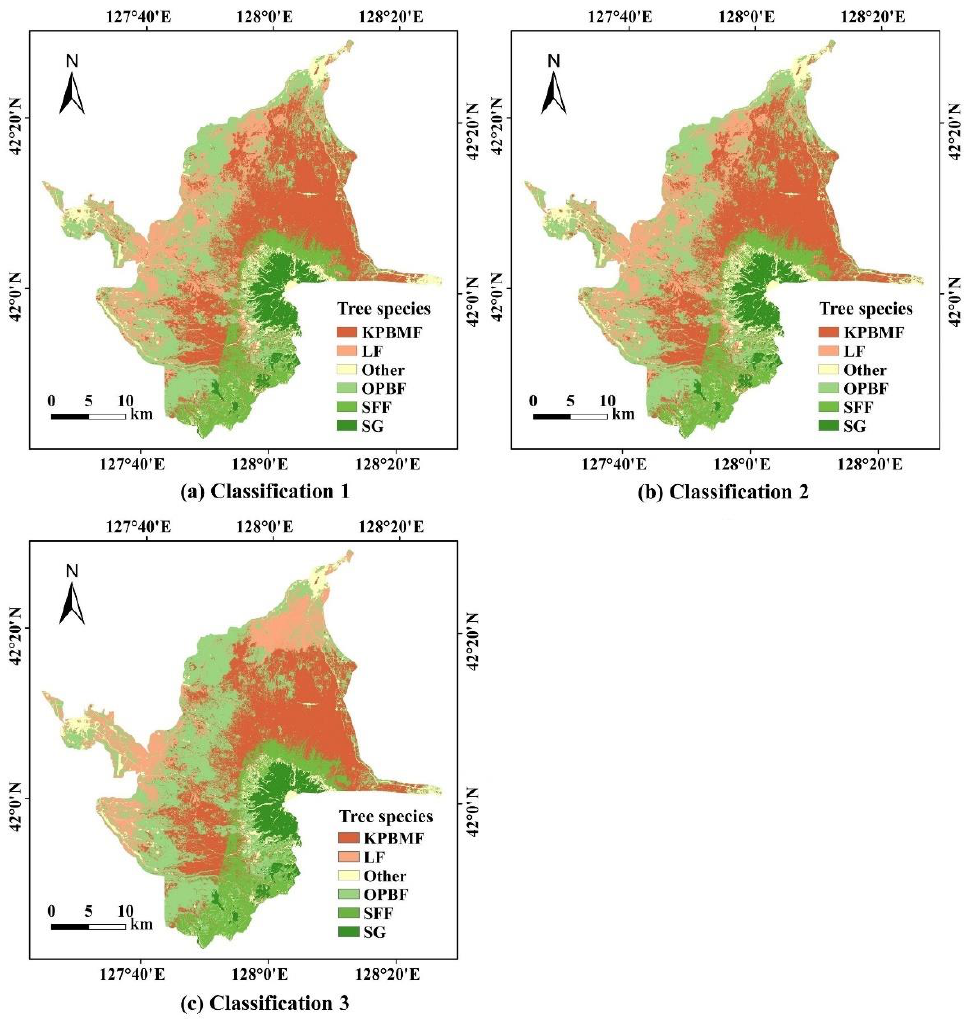
Figure 6. Tree species classification map.